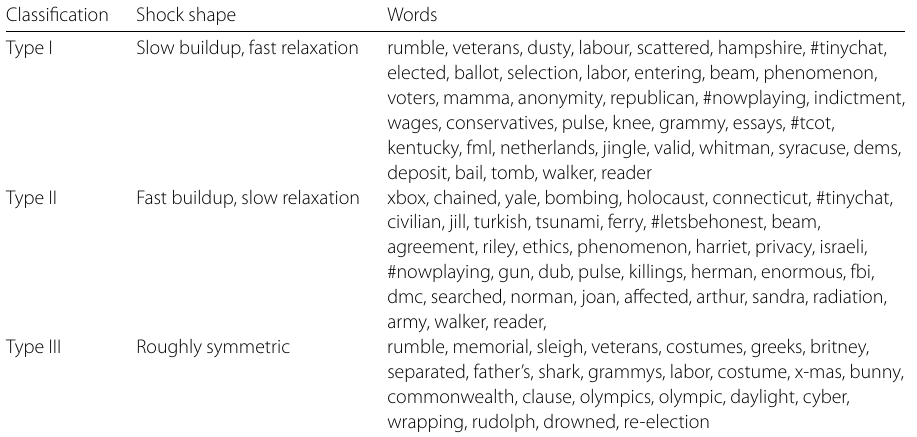
Table 1 Words for which at least one shock segment was close in norm to a spatial mean shock segment as detailed in Sect. 2. We display the distributions of “shock points”—hypothesized deterministic maxima of the noisy mechanistically-generated time series—in Fig. 13. Every word may also have several “shock points” where each point could corresponds to a different shock dynamics due to the way each word is used throughout its life span on the platform, hence a few of these examples (e.g. rumble, anonymity, #nowplaying) appear in multiple